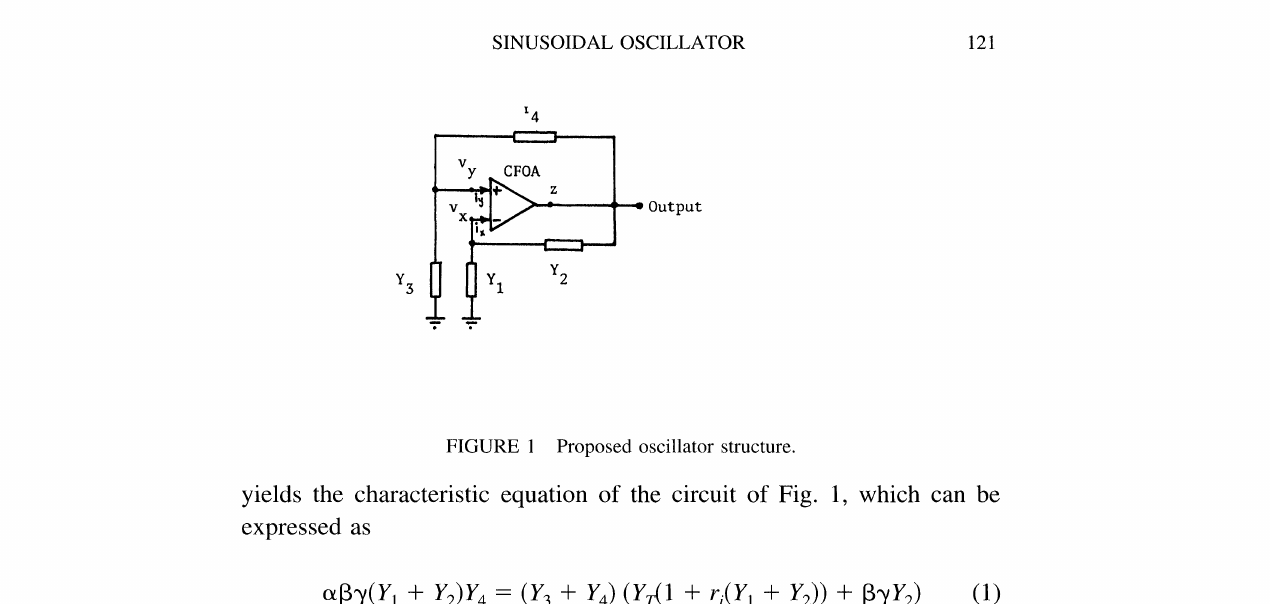
FIGURE Proposed oscillator structure.